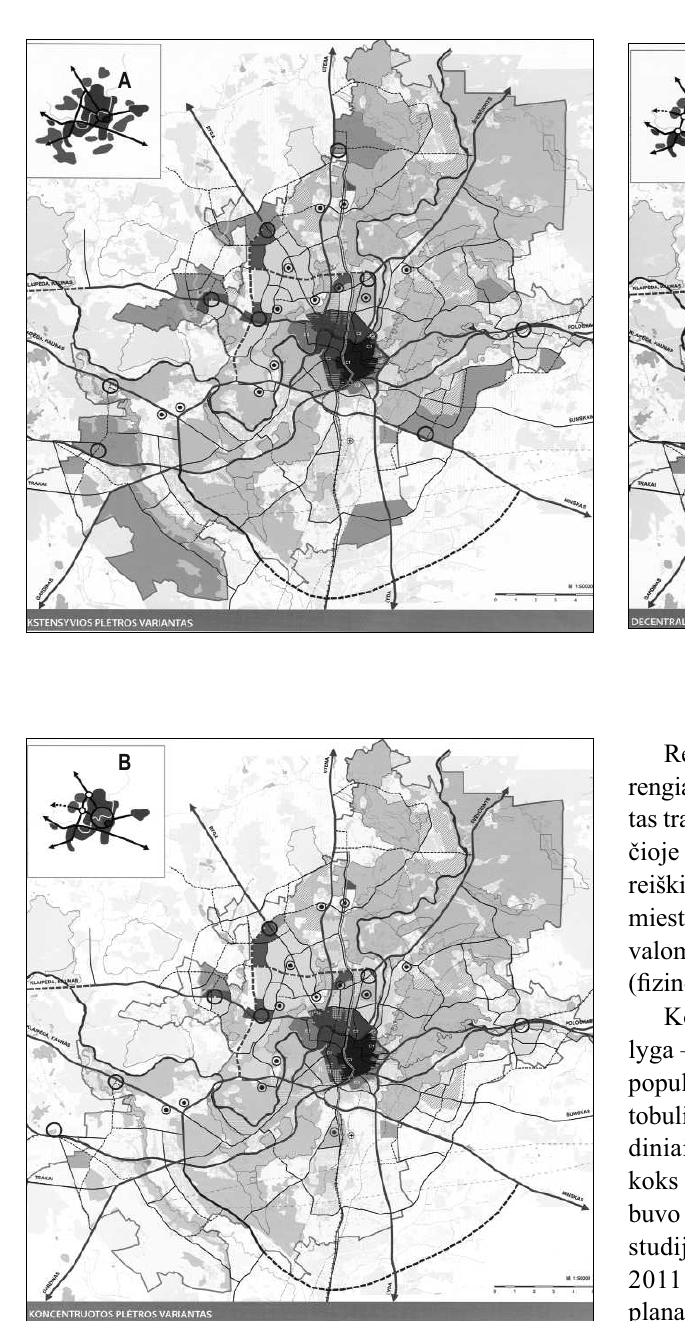
Fig 11. Versions of Vilnius city Master Plan conception develop- ment („Vilniaus planas“, 2005): A – version of exstensive develop- ment; B – version of concentrated development; C – version